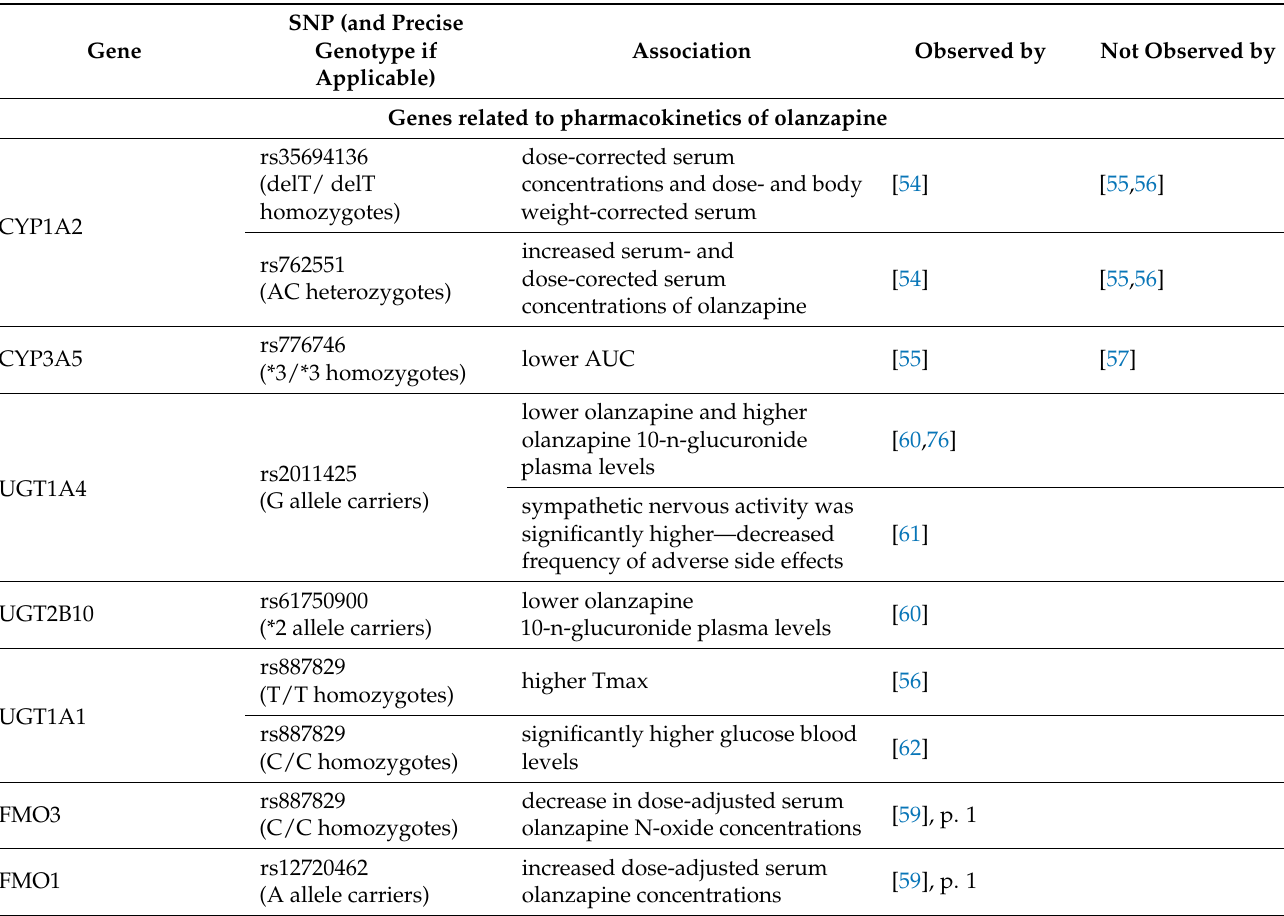
Table 3. Summary of gene polymorphisms which might impact olanzapine